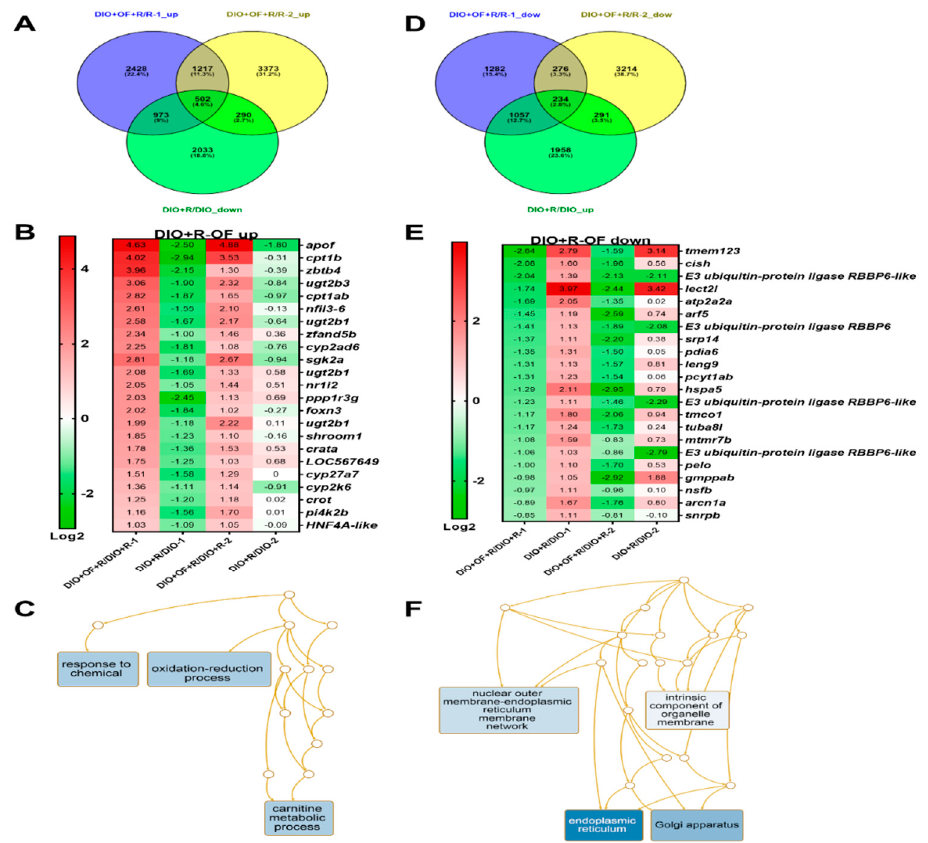
Figure 7. GeneTitan array analysis of the expression profile of HCC transgenic zebrafish following different treatments. ( A ) Venn diagram of upregulation of genes in HCC transgenic zebrafish diet-induced obesity with irradiation and Oligo-Fucoidan pretreatment (DIO + OF + R) compared to irradiation only (DIO + R), overlapping with downregulated in irradiation (DIO + R) compared to no radiation (DIO). ( B ) The heatmap of genes upregulated in Oligo-Fucoidan pretreatment but downregulated by irradiation. First batch is HBx, src transgenic fish with 40 Gy (1), and second batch is HBx, src, p53-transgenic fish with 10 Gy (2). ( C ) Gene ontology analysis of Oligo-Fucoidan induced genes in irradiated transgenic fish. ( D ) Venn diagram of downregulation of genes in HCC transgenic zebrafish diet-induced obesity with irradiation and Oligo-Fucoidan pretreatment (DIO + OF + R) compared to irradiation only (DIO + R), overlapping with downregulated in irradiation (DIO + R) compare to no radiation (DIO). ( E ) The heatmap of genes downregulated in Oligo-Fucoidan pretreatment but upregulated by irradiation. First batch is HBx, src transgenic fish with 40 Gy (1), and second batch is HBx, src, p53-transgenic fish with 10 Gy (2). ( F ) Gene ontology analysis of Oligo-Fucoidan repressed genes in irradiated transgenic